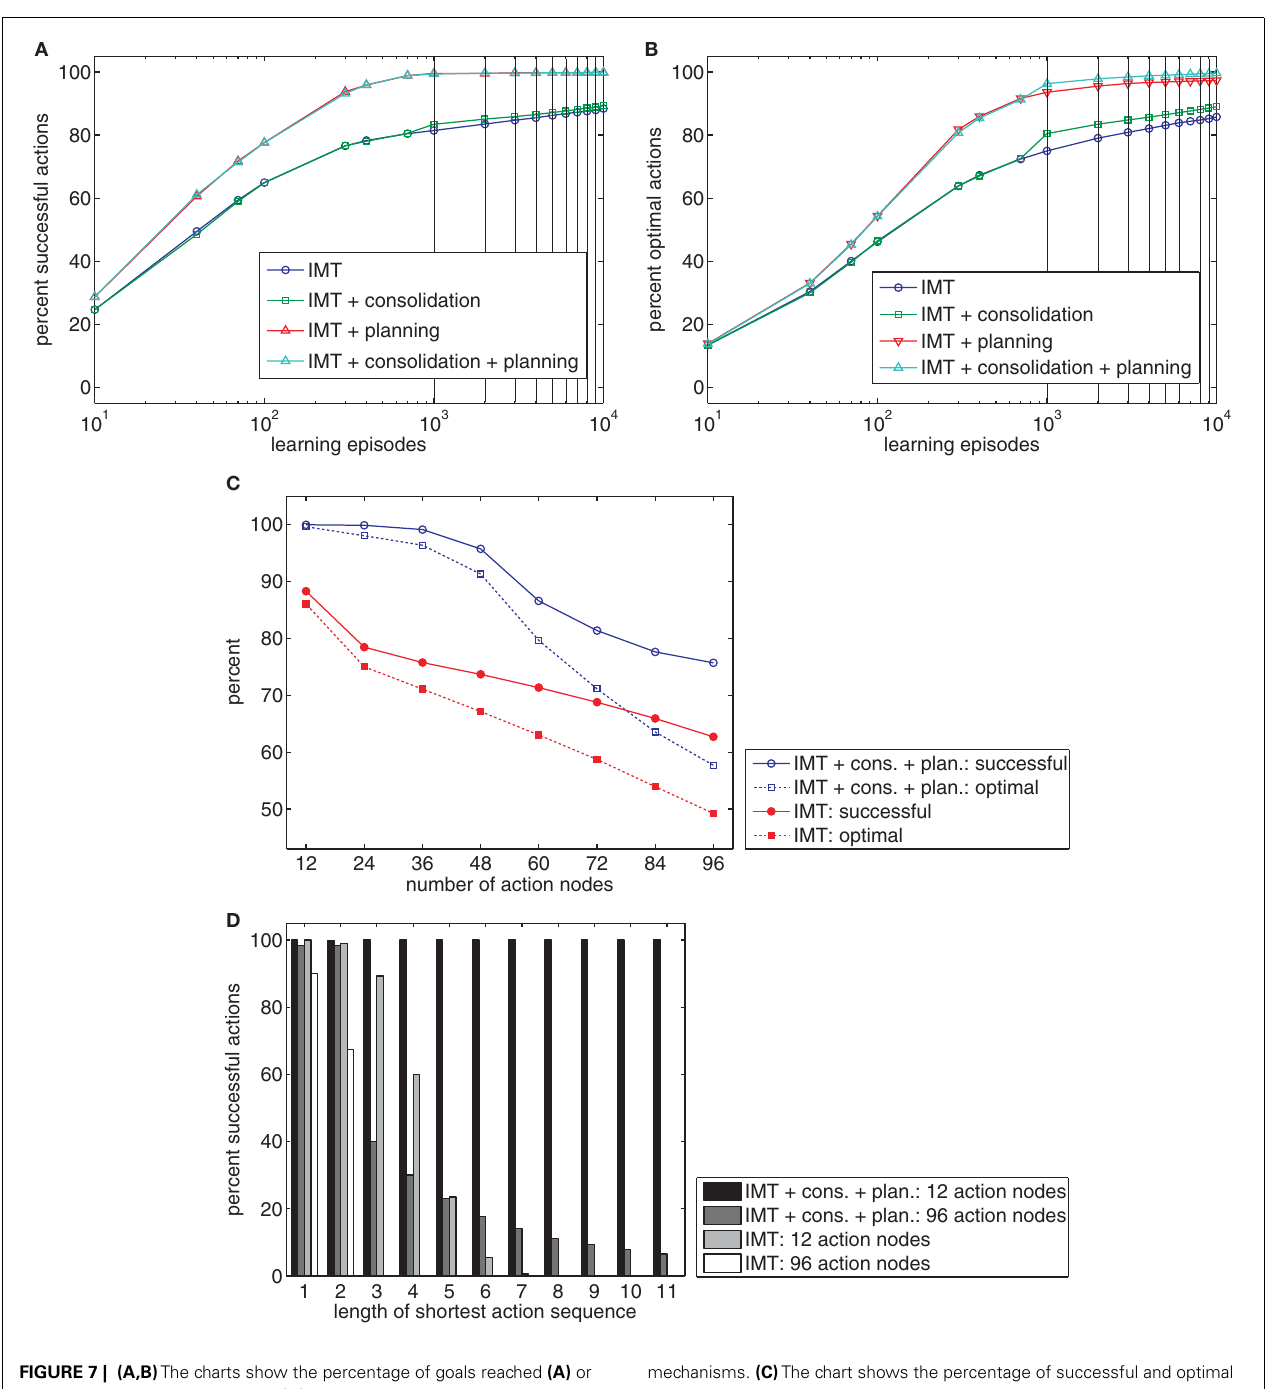
FIGURE 7 | (A,B) The charts show the percentage of goals reached (A) or reached in the most efficient way (B) after different numbers of learning episodes. Four models were tested: pure IdeomotorTheory (IMT), an extension of IMT with a consolidation mechanism, an extension of IMT with a